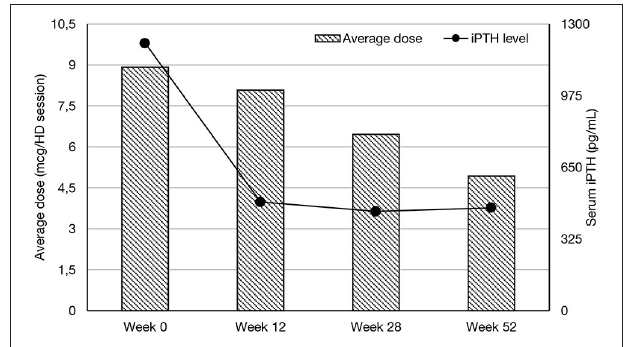
FIGURE 2 | Average dose of paricalcitol during observation